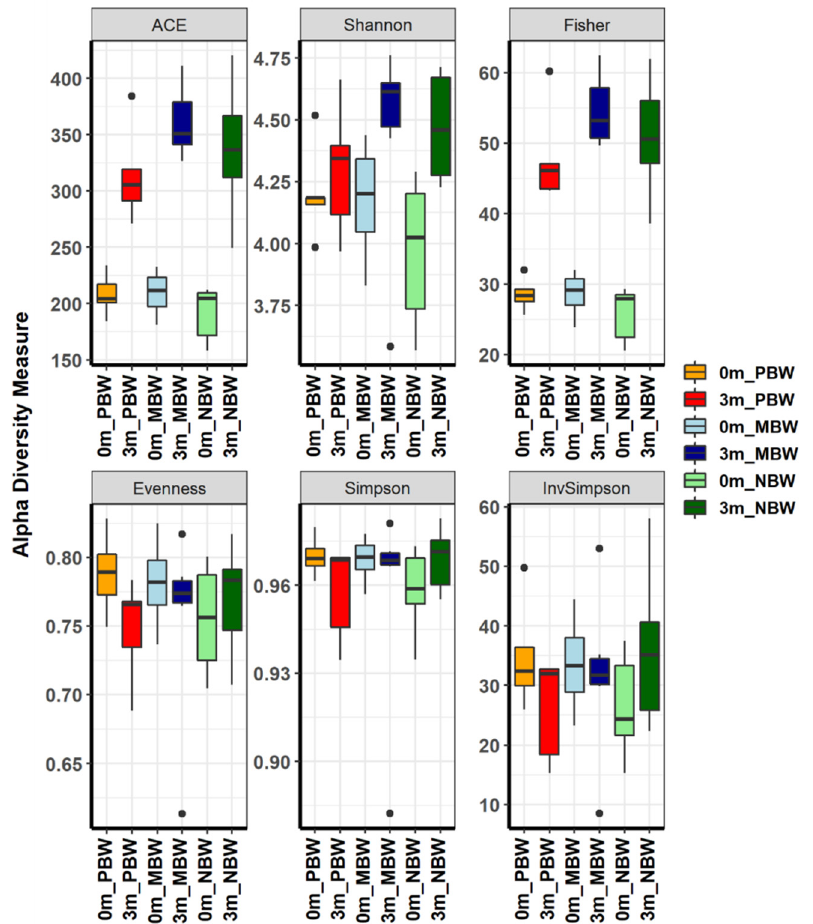
Figure 4. The α -diversity indices of the gut microbiome of the PBW, MBW, and NBW groups. Species richness and diversity calculated by ACE richness, Shannon diversity and Fisher’s alpha, evenness, Simpson, and inverse Simpson for the PBW, MBW, and NBW groups are shown for before and after the gut microbiome replacement .